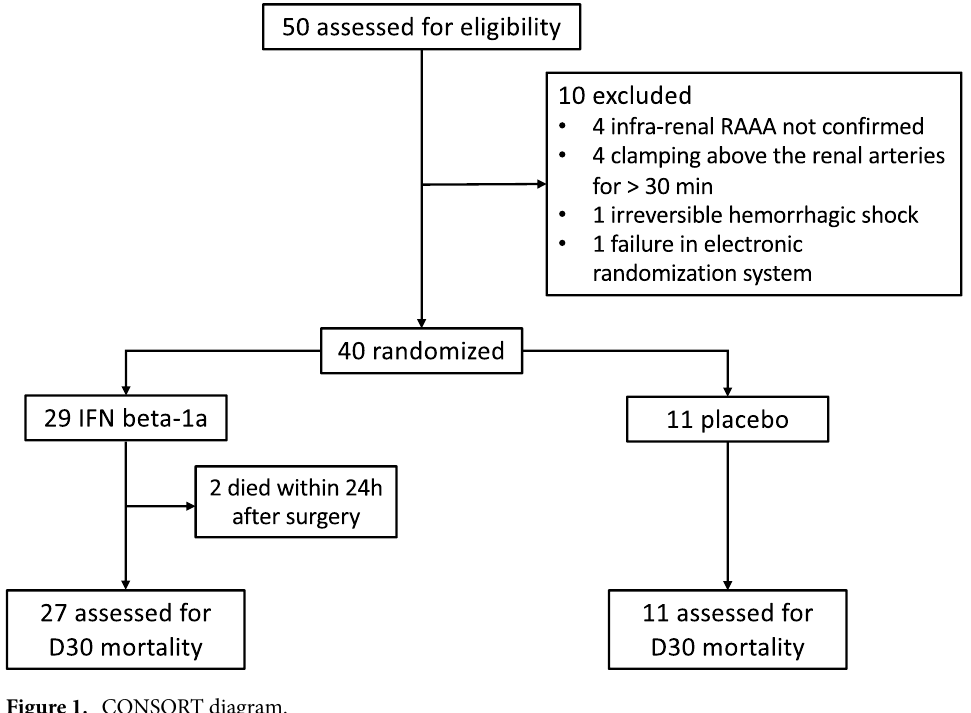
Figure 1. CONSORT